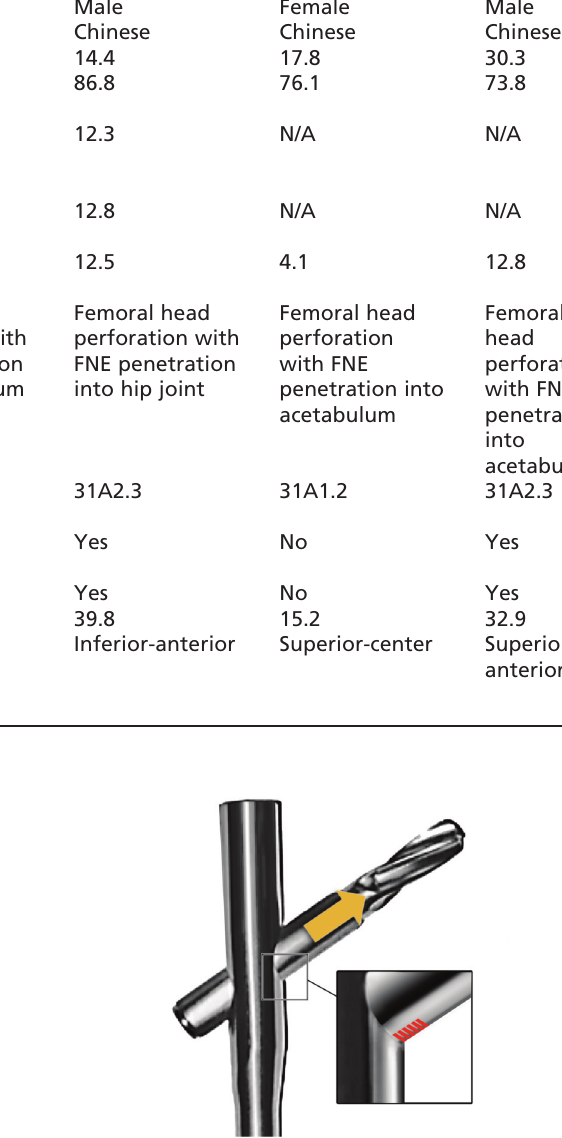
Plain radiographs post fixation of the pertrochanteric Fig. 1: left femur fracture with a cephalomedullary device (Synthes proximal femur antirotation nail, PFNA) (a) Immediate postop (b) Subsequent impaction of the fracture with gradual lateral migration of the femoral neck element with respect to the intramedullary nail component (red arrow) (c) Medial migration of the femoral neck element with respect to the intramedullary nail component with perforation of the femoral head and penetration of the acetabulum (red arrow).